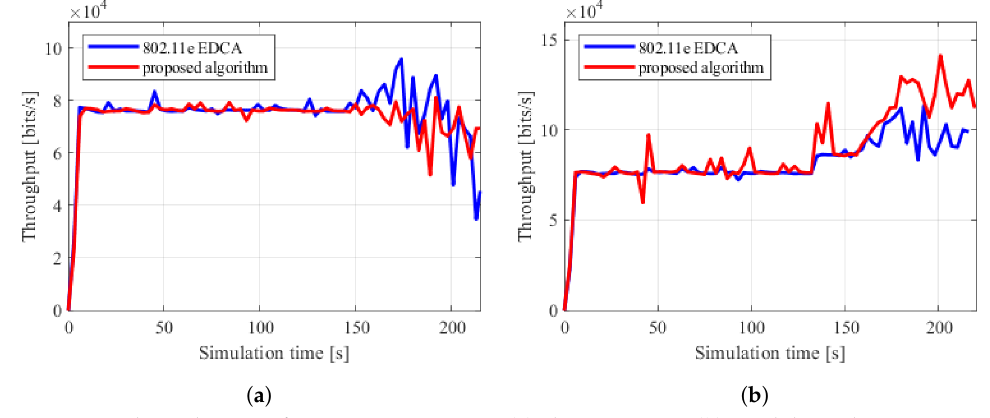
Figure 11. Throughput performance comparison. ( a ) Short message. ( b ) Total throughput.